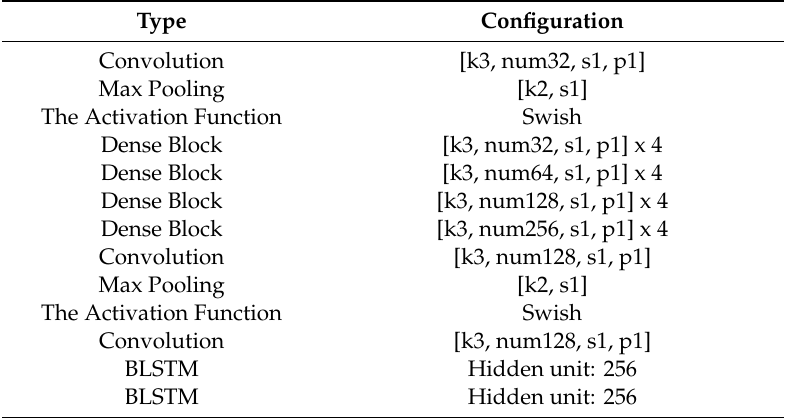
Table 2. Detailed parameters of EN